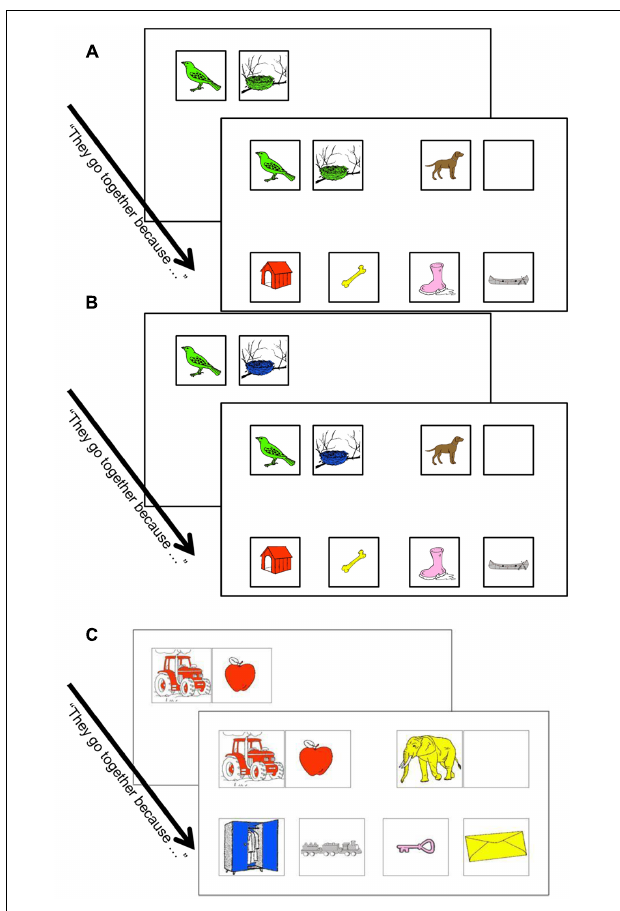
FIGURE 2 | Examples of AB-Color-Semantic-match (A) of AB-Semantic-match trials (B) and color trials (C) in Experiment 2. In the color trials, the “non-solution” stimuli were not semantically related to C. Examples coming from the AB-first + Verbalization condition.